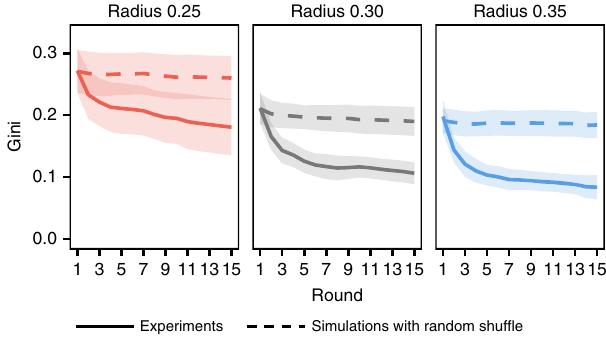
Fig. 4 Changes in Gini coef fi cient across rounds. The solid lines show the average of experimental results; the dashed lines show the expected value when each individual randomly allocates their resources while preserving the diversity of the allocation from the experiment. Shaded areas denote 95% con fi dence intervals ( N = 10). The actual subjects reduced wealth inequality through their interactions, compared to identical circumstances where their resources were randomly